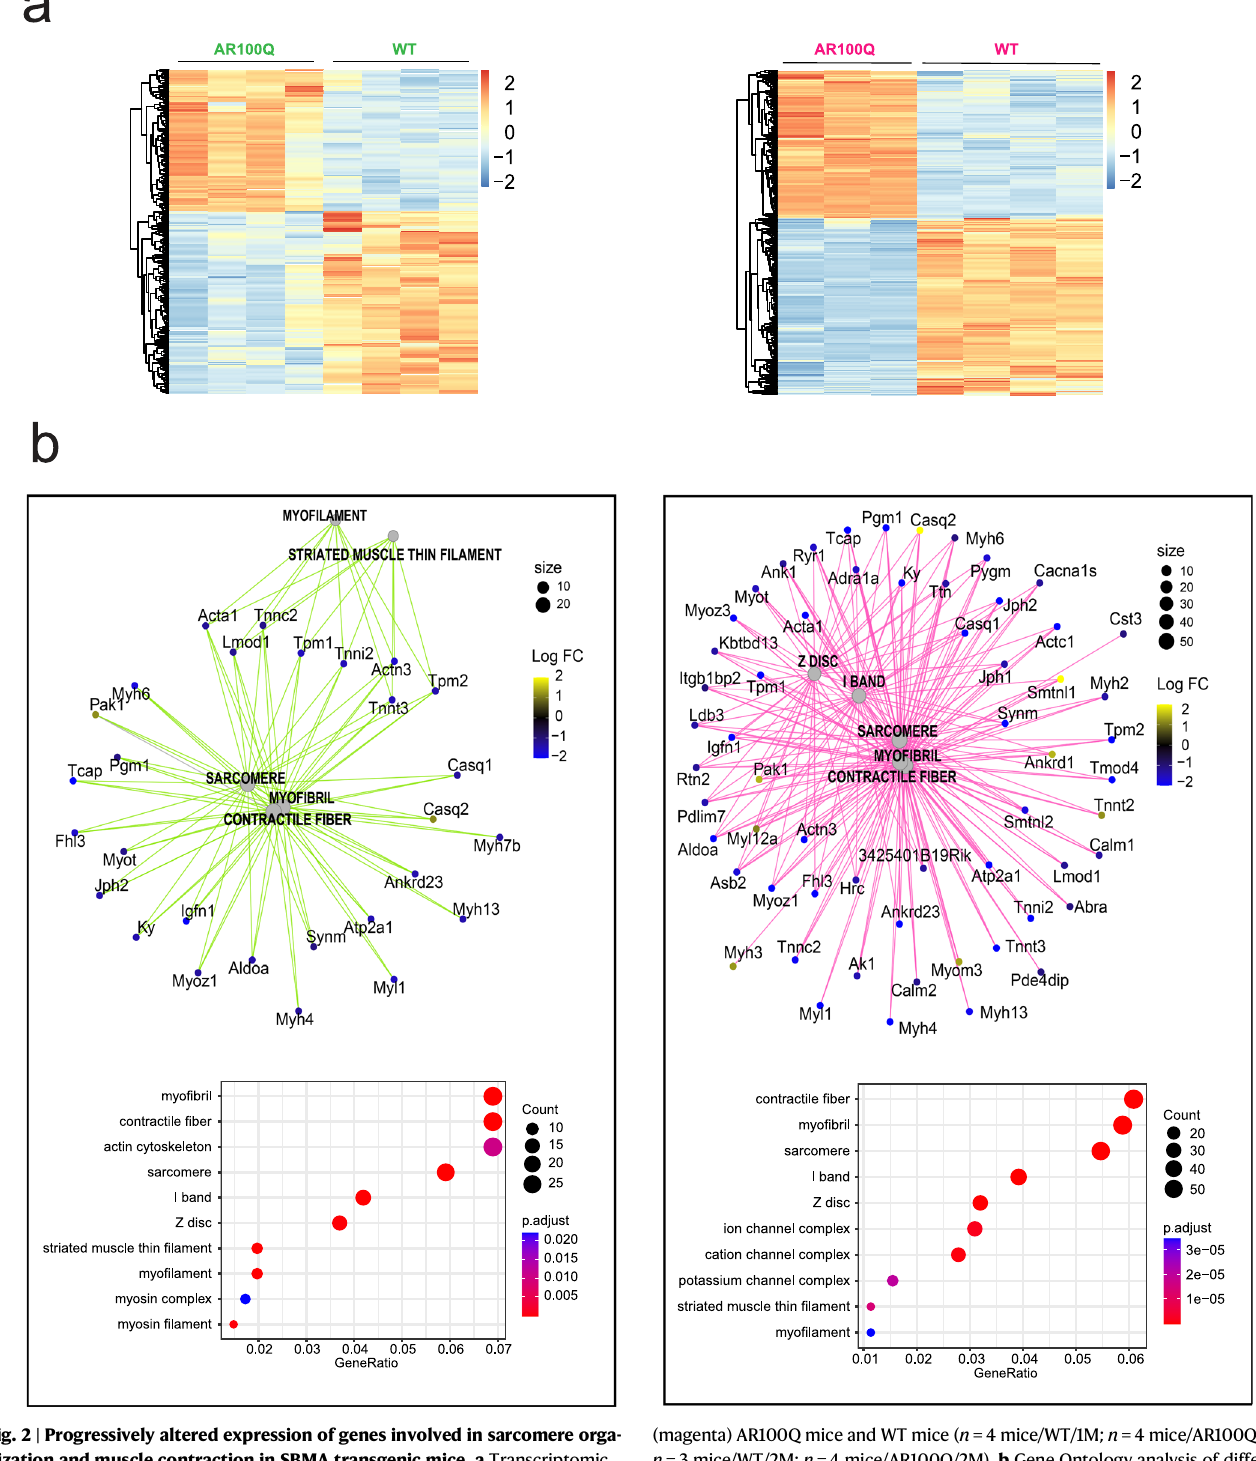
(magenta) AR100Q mice and WT mice ( n =4 mice/WT/1M; n =4 mice/AR100Q/1M; n =3 mice/WT/2M; n =4 mice/AR100Q/2M). b Gene Ontology analysis of differen- tially expressed genes in the category “ cellular component ”